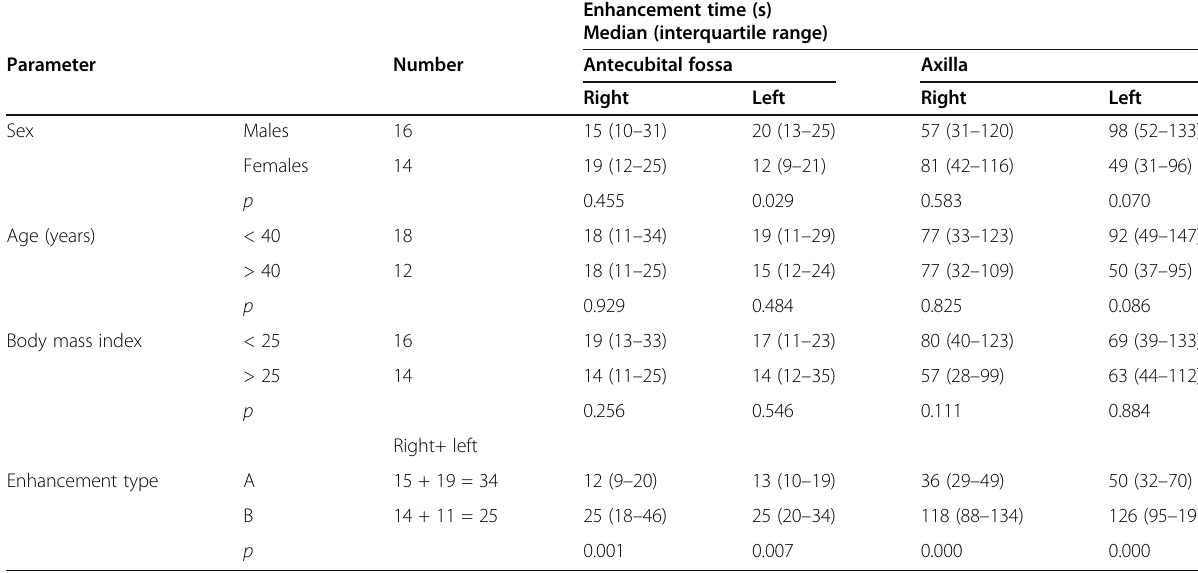
Table 2 Effect of different parameters on the enhancement time after successful intradermal injections